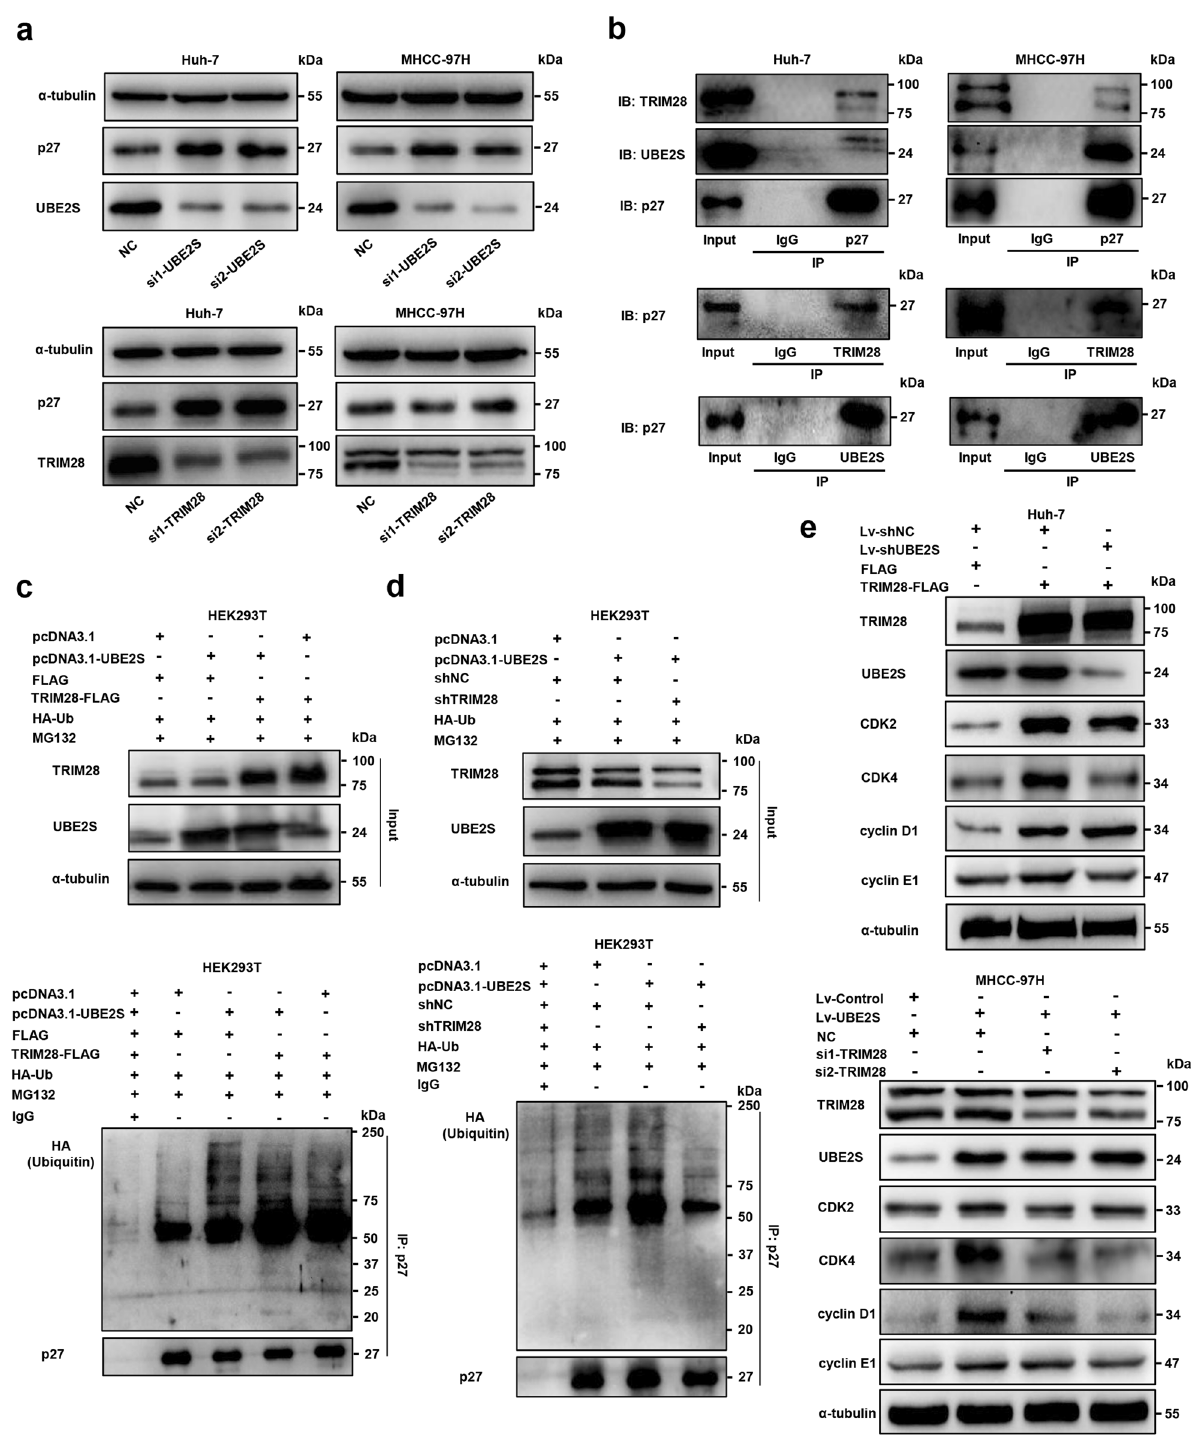
Fig. 4 UBE2S and TRIM28 enhance the ubiquitination of p27 and regulate cell cycle progression. a Expression of p27 assessed by western blot analysis in HCC cells with UBE2S or TRIM28 silencing. b Endogenous interaction of UBE2S, TRIM28 and p27 in HCC cells. c – d Ubiquitination of p27 in HEK293T cells with UBE2S and TRIM28 overexpression or knockdown in the presence of MG132 (10 μ M, 12 h) detected by immunoprecipitation and western blot analysis. e Differential expressions of cell cycle markers, including CDK2, CDK4, cyclin D1, and cyclin E1, were evaluated in HCC cells in which UBE2S and TRIM28 were elevated or silenced respectively, to enhance the ubiquitination of p27, thus promoting overexpressed. Importantly, we found that UBE2S, TRIM28, and cell cycle progression in HCC. Rupali et al. 40 reported that the p27 could interact with each other in different HCC cells. Considering the cascading mode of ubiquitination, these results degradation of protein occurs not in the cytosol but in the indicate that UBE2S and TRIM28 may act as E2s and E3s, nucleus. Although we have found UBE2S could interact with Signal Transduction and Targeted Therapy (2021)